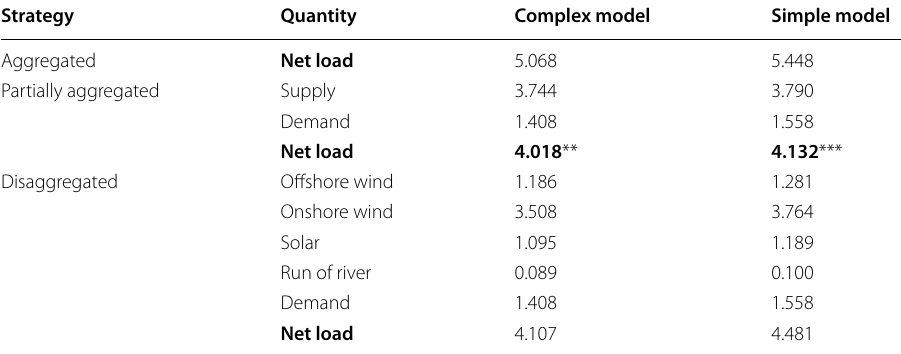
The best performing strategy is highlighted in bold. Significance levels are based on the DM test and show the significance between the two best performing forecasting strategies for the same forecasting model Significance levels *** α = 0.001 , ** α = 0.01 , * α =